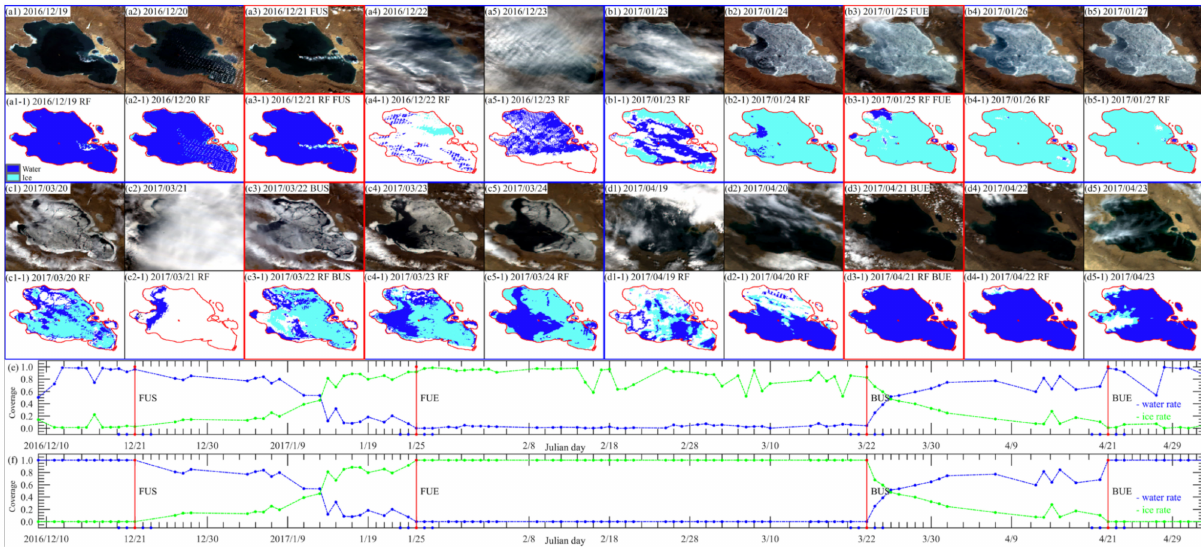
Figure 5. Water / ice results of RF using the cloud filtering algorithm for one full ice season from 10 December 2016 to 29 April 2017 (( a1 – a5 ). MODIS images for five consecutive days in FUS; ( a1-1 – a5-1 ). Corresponding water / ice results of RF for five consecutive days in FUS; ( b1 – b5 ). MODIS images for five consecutive days in FUE; ( b1-1 – b5-1 ). Corresponding water / ice results of RF for five consecutive days in FUE; ( c1 – c5 ). MODIS images for five consecutive days in BUS; ( c1-1 – c5-1 ). Corresponding water / ice results of RF for five consecutive days in BUS; ( d1 – d5 ). MODIS images for five consecutive days in BUE; ( d1-1 – d5-1 ). Corresponding water / ice results of RF for five consecutive days in BUE; ( e ). Water coverage, ice coverage results; ( f ). Water coverage, ice coverage through cloud filtering. Red boxes and lines represent FUS, FUE, BUS, and BUE, and cloudy images were deleted for the following dates; 2016 / 12 / 22, 2016 / 12 / 23, 2017 / 01 / 23, 2017 / 03 / 21, and 2017 / 04 /